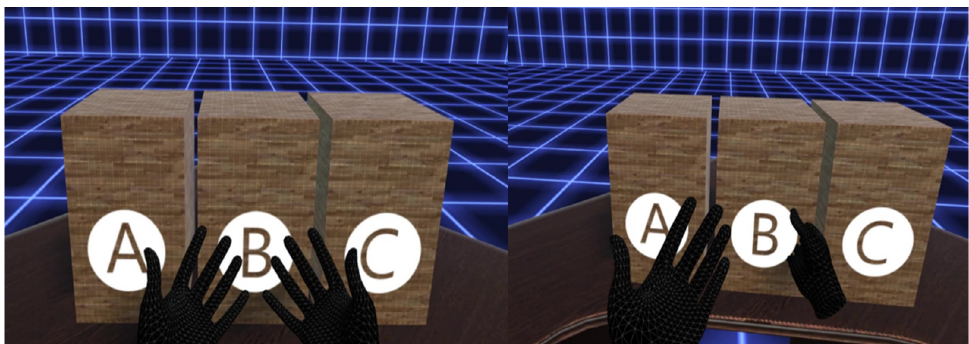
Figure 7. Screenshot of the scene in Experiment 1. The experiment was constructed so that the weight felt different by applying different offsets to objects A , B and C . Participants may think the weight was heavy or light in the order in which the objects were listed, so B was set as the heaviest weight.